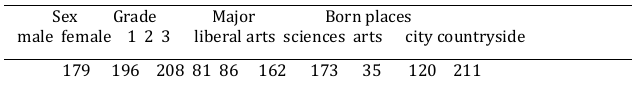
Table 1: Sample Distribution of